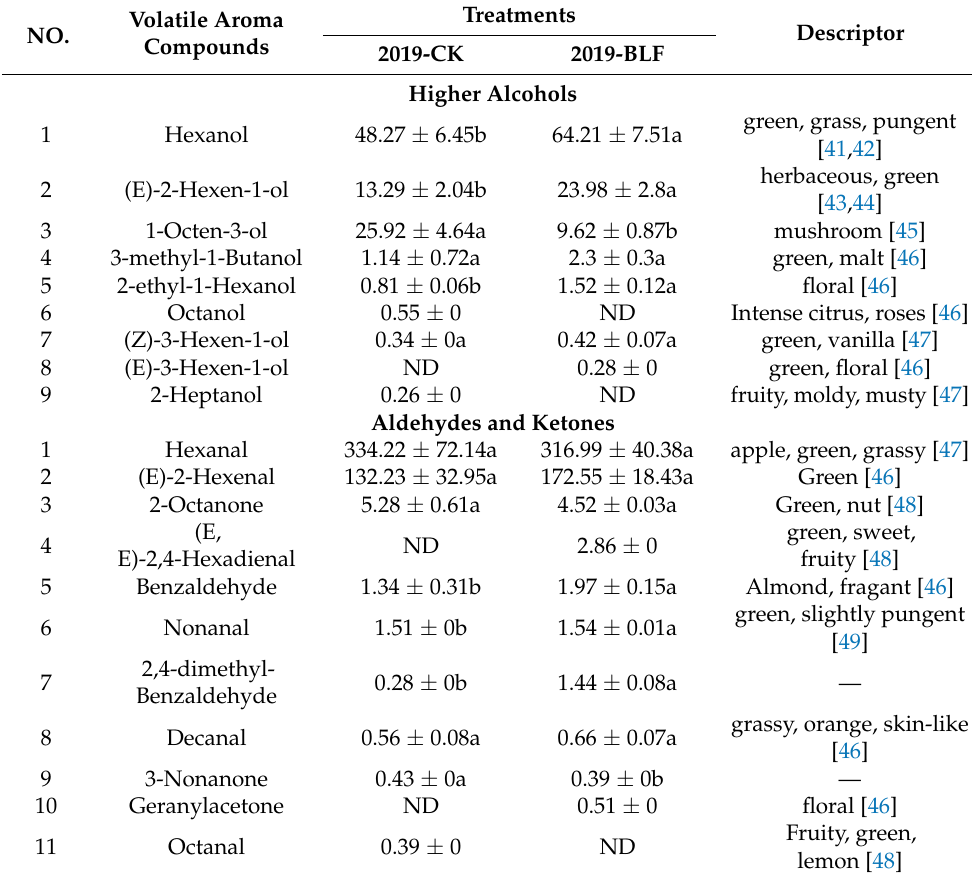
Table 5. Relative concentrations of volatile compounds in ‘Cabernet sauvignon’ grapes from BLF and CK treatments in 2019.